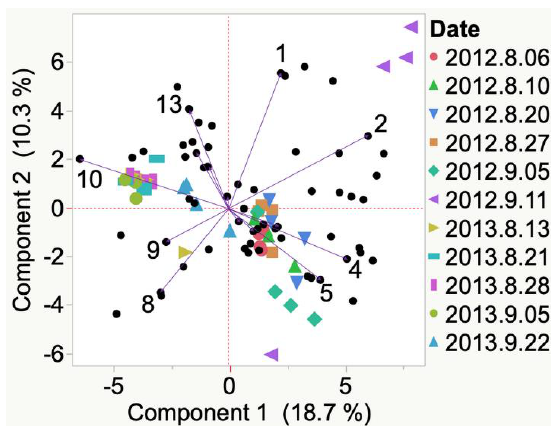
Figure 9. Evolution of VOCs emitted from crushed berries from veraison to harvest of 2012 and 2013 Frontenac grapes grown in South Dakota. Key to most representative volatiles from HCA, shown as vectors from the origin and read clockwise: 1 = Nonane, 2 = Styrene, 3 = Octanal, 4 = Acetaldehyde, 5 = 1-Hexanol, 6 = Benzoic acid, methyl ester, 7 = Isophorone, 8 = Ethyl hexanoate, 9 = N -benzyl-2-phenethylamine, 10 = Acetone, 11 = Ethyl palmitate, 12 = Hexanoic acid, 13 = 2-Methyl-1-propanol, 14 = 2-Octanone.